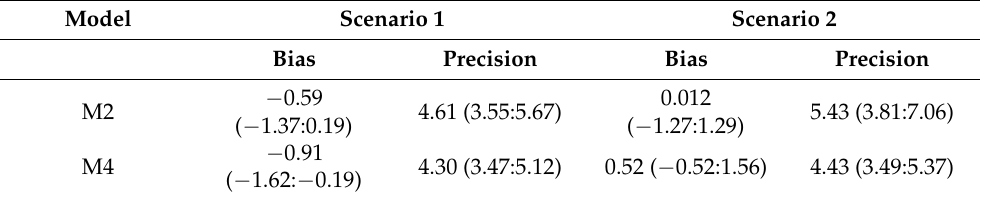
Table 4. Values of bias and precision with its 95% confidence interval for each model in both scenarios.